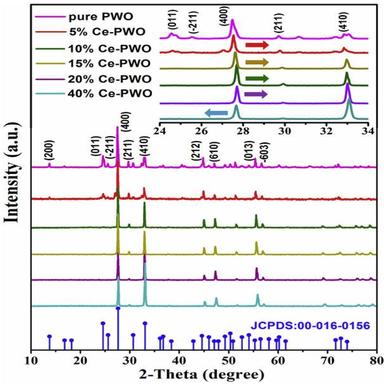
XRD patterns of the PbWO4 doped with Ce at different molar fractions.